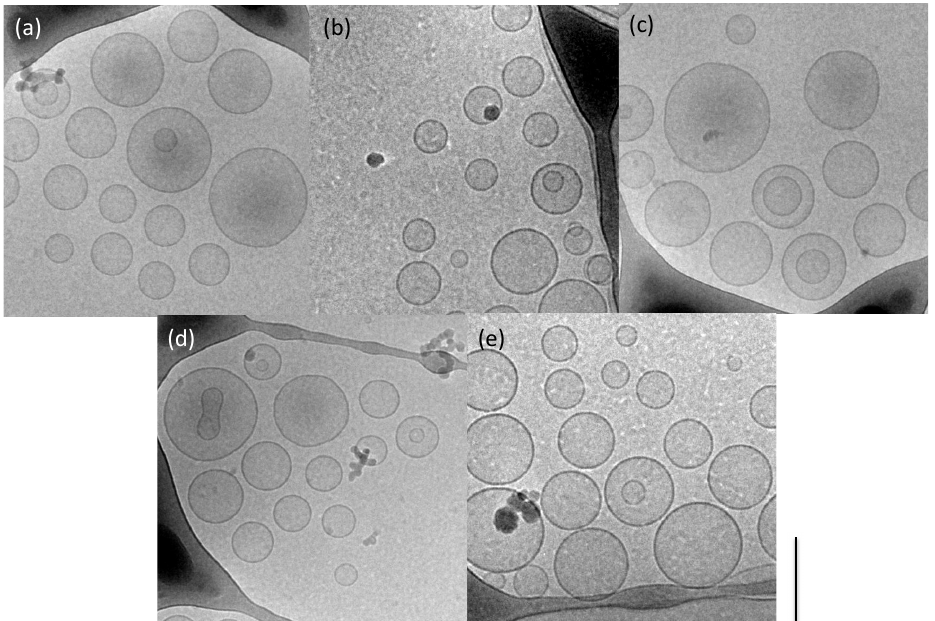
Figure 4. Cryo-TEM images of the produced unloaded anionic liposomes visualized after extrusion. Plain-LP ( a ), LP-SD ( b ), LP-NLS ( c ), LP-PAG ( d ) and LP-SLL ( e ), Bar corresponds to 250 nm.